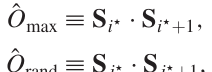
FIG. 8. Heat maps for the distributions of h a j ˆ O a i (right) over several ( ≳ 25000 ) eigenstates. Here, h a j rand j S 0 ¼ 0 , L ¼ 22 , and α ∈ f 0 . 3 ; 0 . 6 ; 1 . 3 g (top to bottom). The concentration of the y marginals around 0 denotes increasingly ergodic behavior (see the comments in the